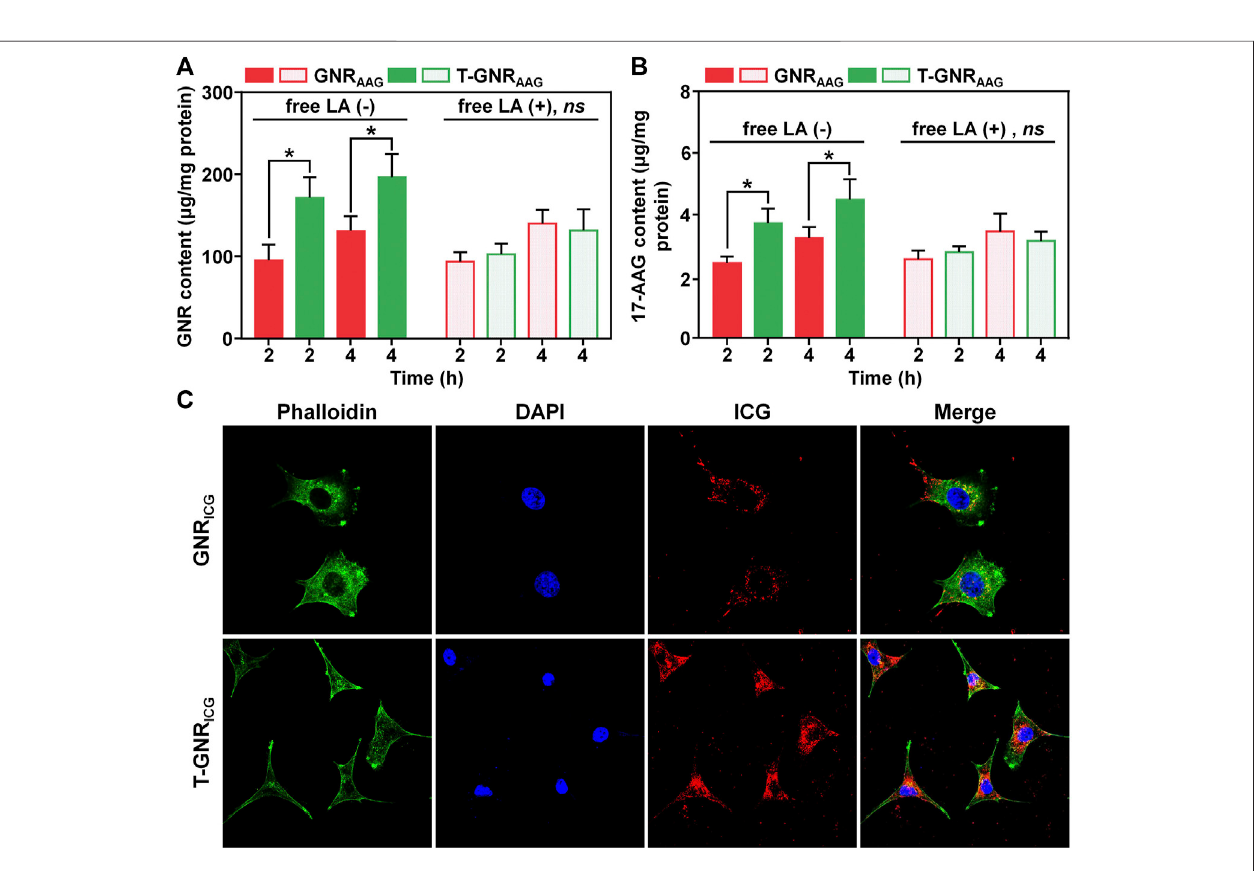
FIGURE 4 | Quantitative cellular uptake of GNR AAG and T-GNR AAG on HepG2 cells detected by ICP-MS (A) and UV-vis spectrophotometry (B) . (C) CLSM observation of internalization of GNR ICG and T-GNR ICG on HepG2 cells. DAPI (blue) and Alexa Fluor 488 phalloidin (green) were used to stain cell nuclei and F-actin,